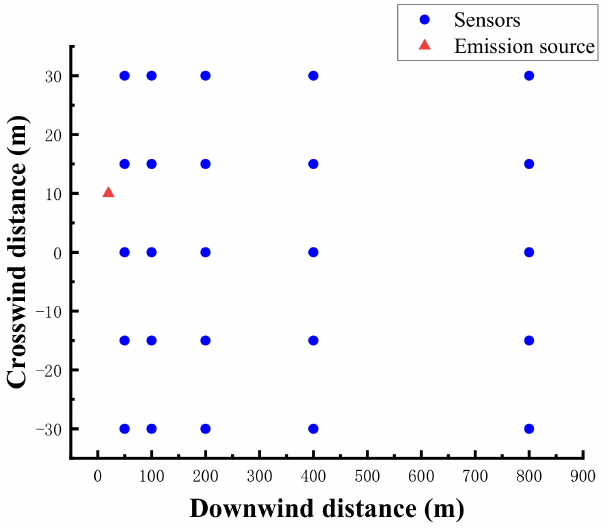
Figure 2. Distribution of leakage source and sensors in simulation